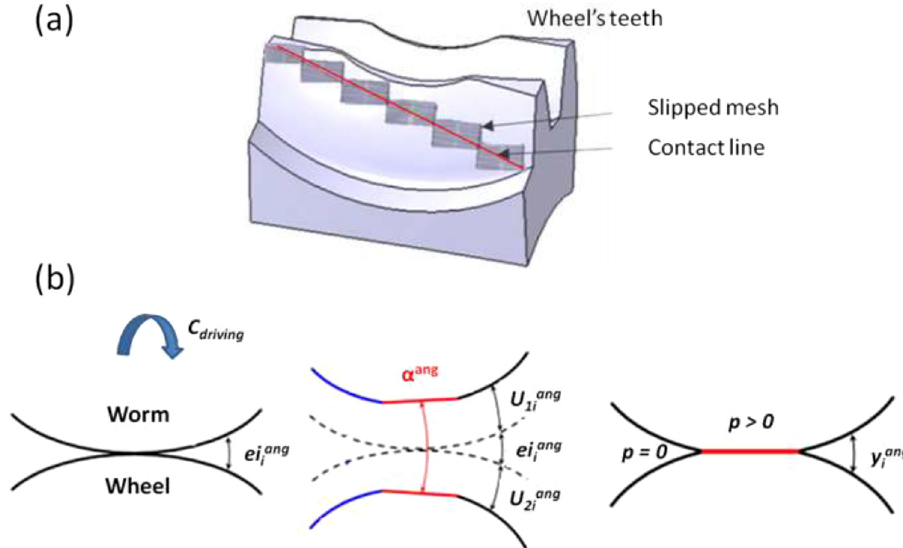
Fig. 3. (a) Unloaded contact zone. (b) Parameters involved in the equations of compatibility of displacements and the equation of load